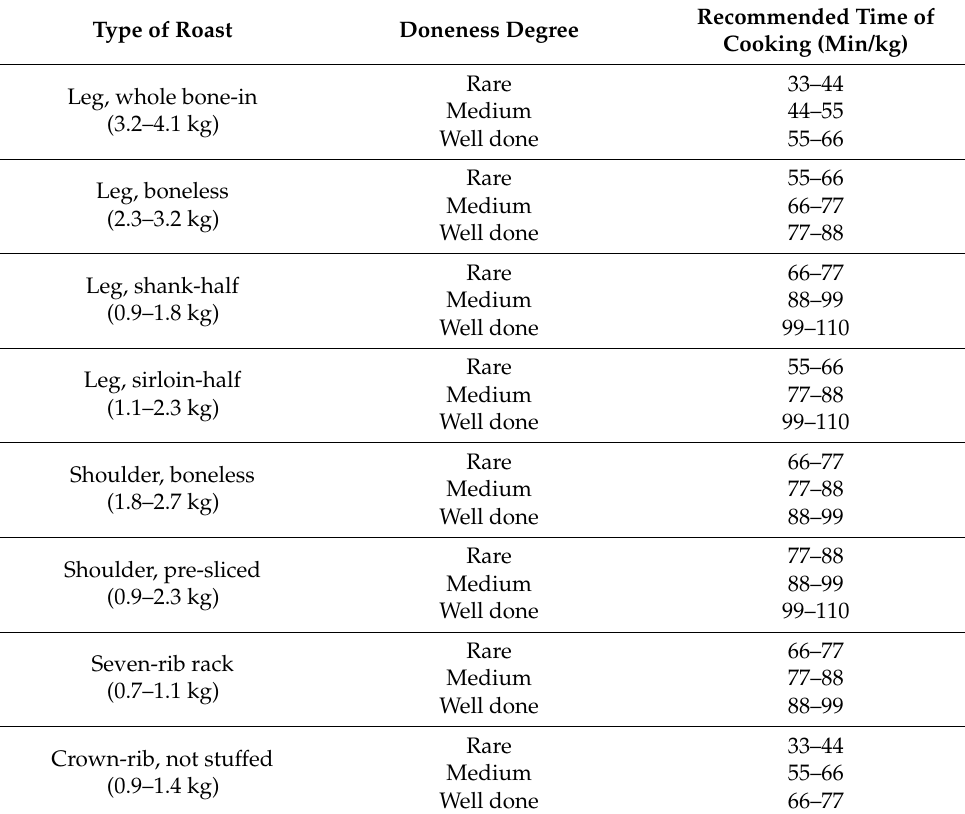
Table 3. Cooking time (min/kg) for roast lamb in varying doneness